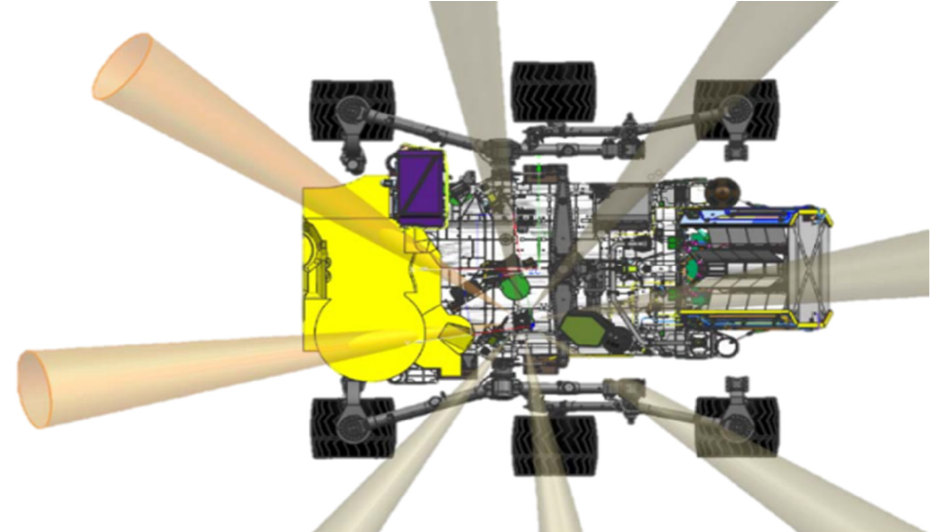
Figure 2. RDS final position on the M2020 rover with its lateral channels FoV represented.